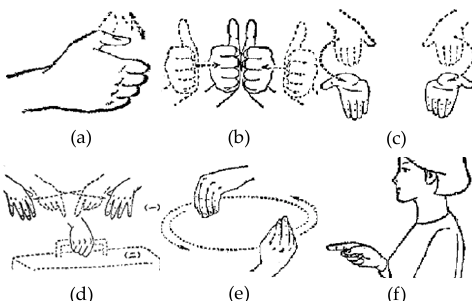
Figure 5. Sign language schematic. The figure shows six classes of sign language extracted from the database: ( a ) sign: “thanks”; ( b ) sign: “friend”; ( c ) sign: “what”; ( d ) sign: “luggage”; ( e ) sign: “communicate”; ( f ) sign: “you”.